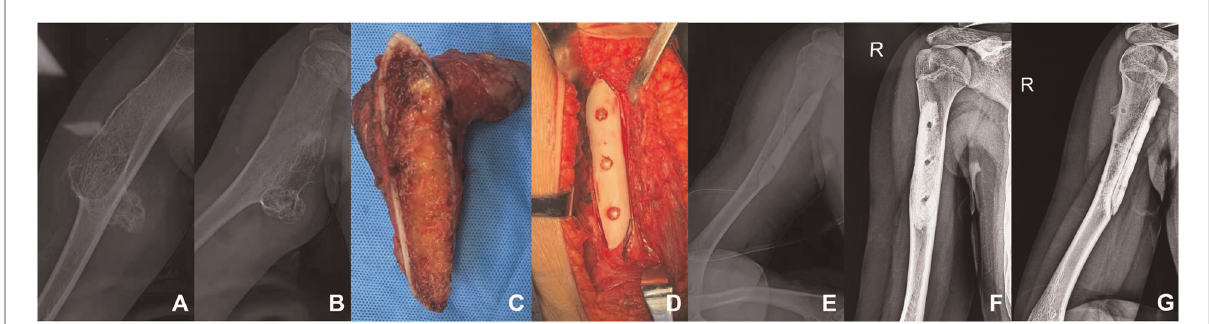
FIGURE 1 A patient with humerus osteochondroma. ( A,B ) The preoperative plain radiographs of the patient showed a huge osteochondroma at the proximal end of the right humerus, with a size of 12 cm * 5 cm * 5 cm. ( C ) Osteotomy was performed from the base of the tumor. ( D ) The allograft was implanted in the bone cortical defect and fi xed with three absorbable screws. ( E ) Immediate postoperative radiographs. ( E,F ) Six months after the operation, the plain radiographs of the right humerus showed that the effect of bone graft fusion was desirable.